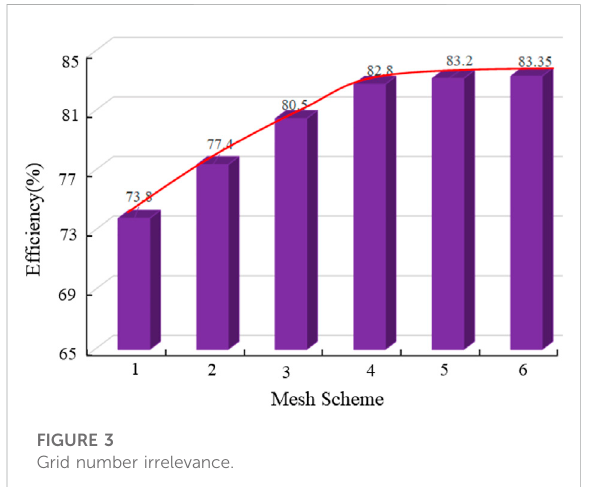
Grid number irrelevance.